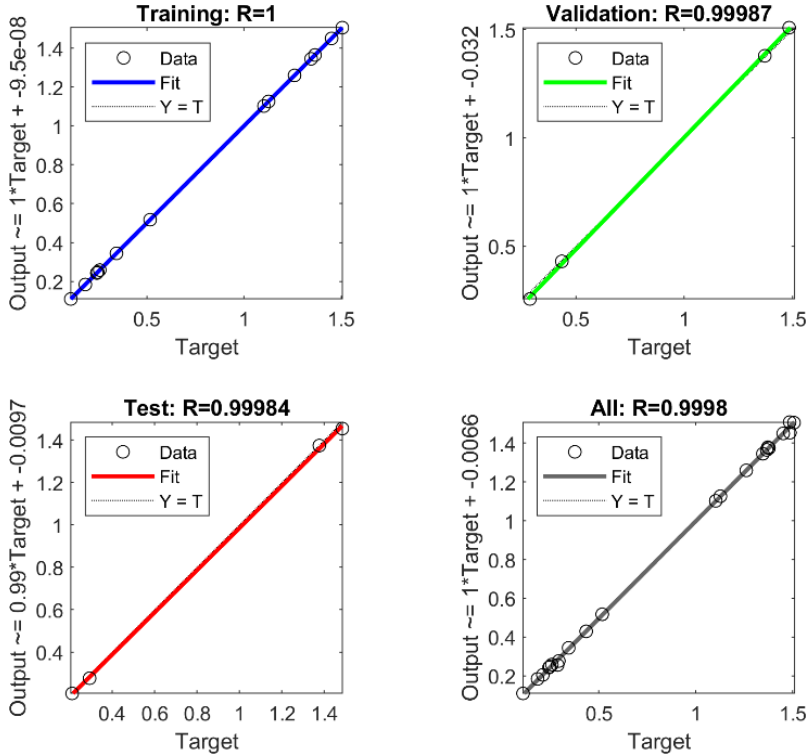
Figure 8. ML training assessment of the Lognormal pdf , which was selected to be best trained for the assigned algorithm model.